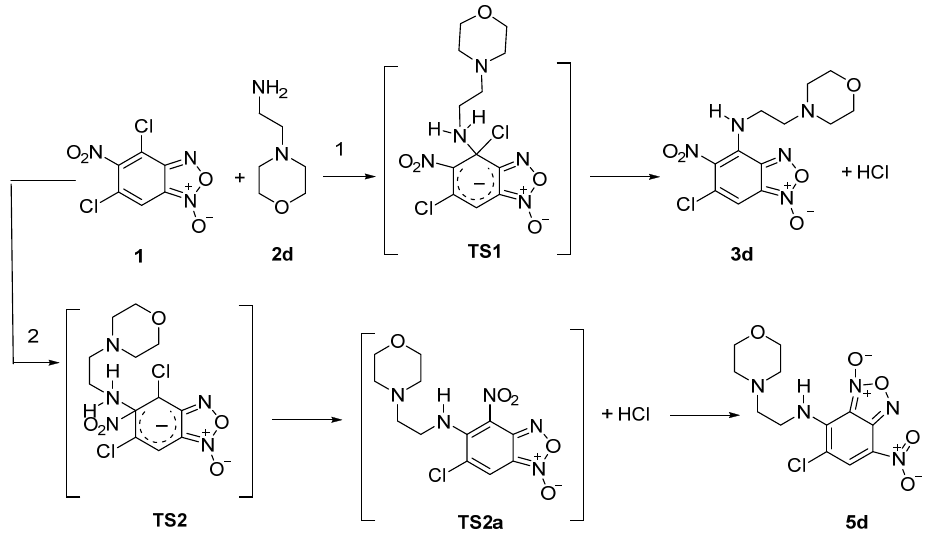
Figure 1. Molecular structures of compound 3 а ( a ), 3d ( b ), 3f ( c ) and 5d ( d ).